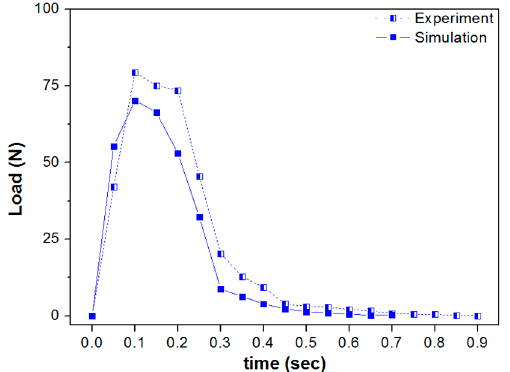
Figure 13. The comparison of forming load between the simulation and experiment.